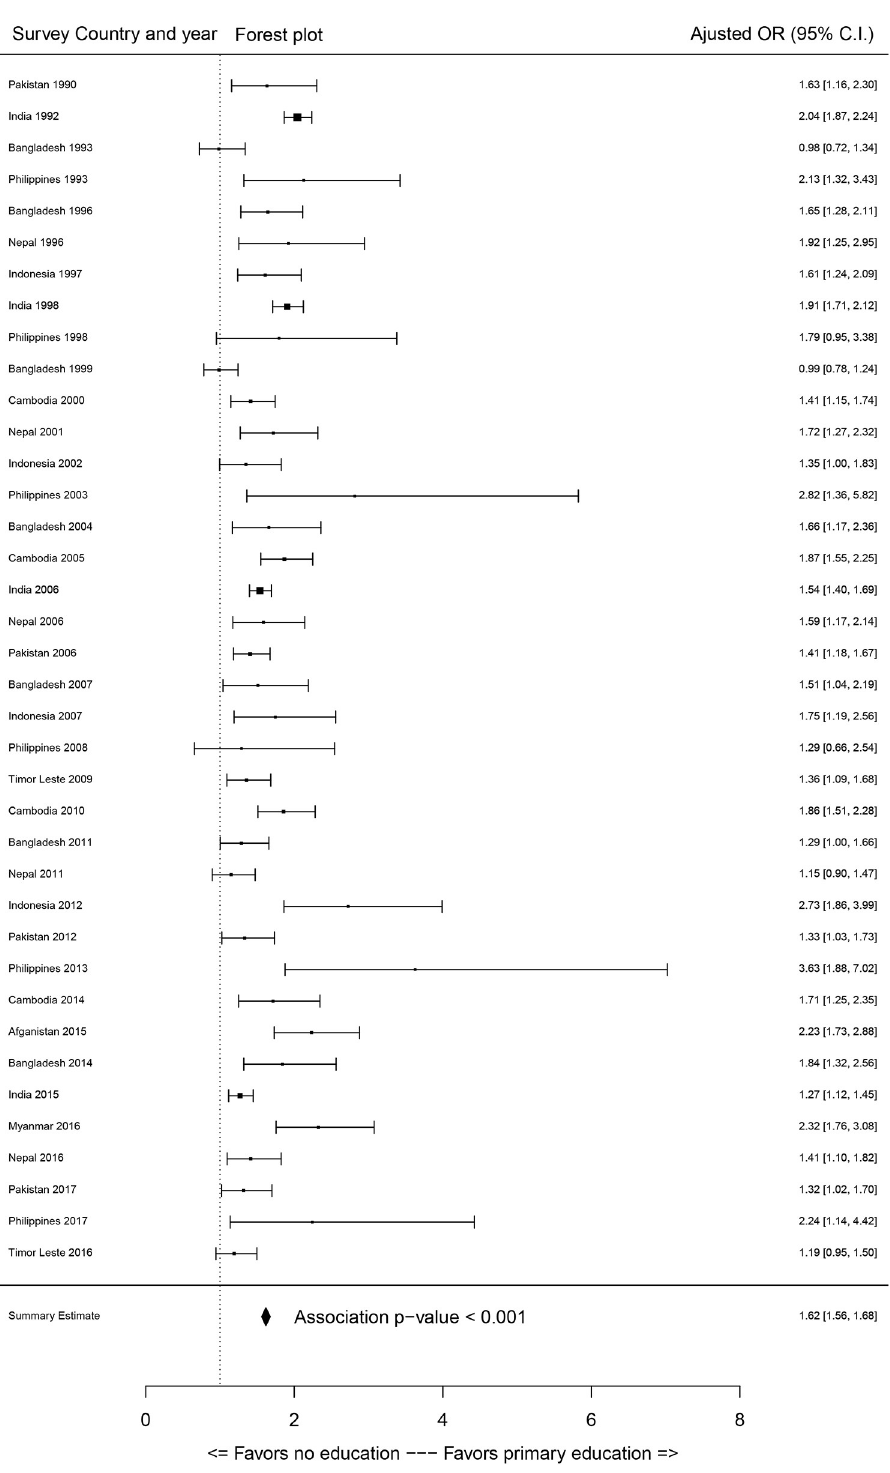
Fig 2. Forest plot of odds of women having primary education on access to skilled birth attendants compared to women with no education (OR = odds ratio, C.I. = confidence interval).